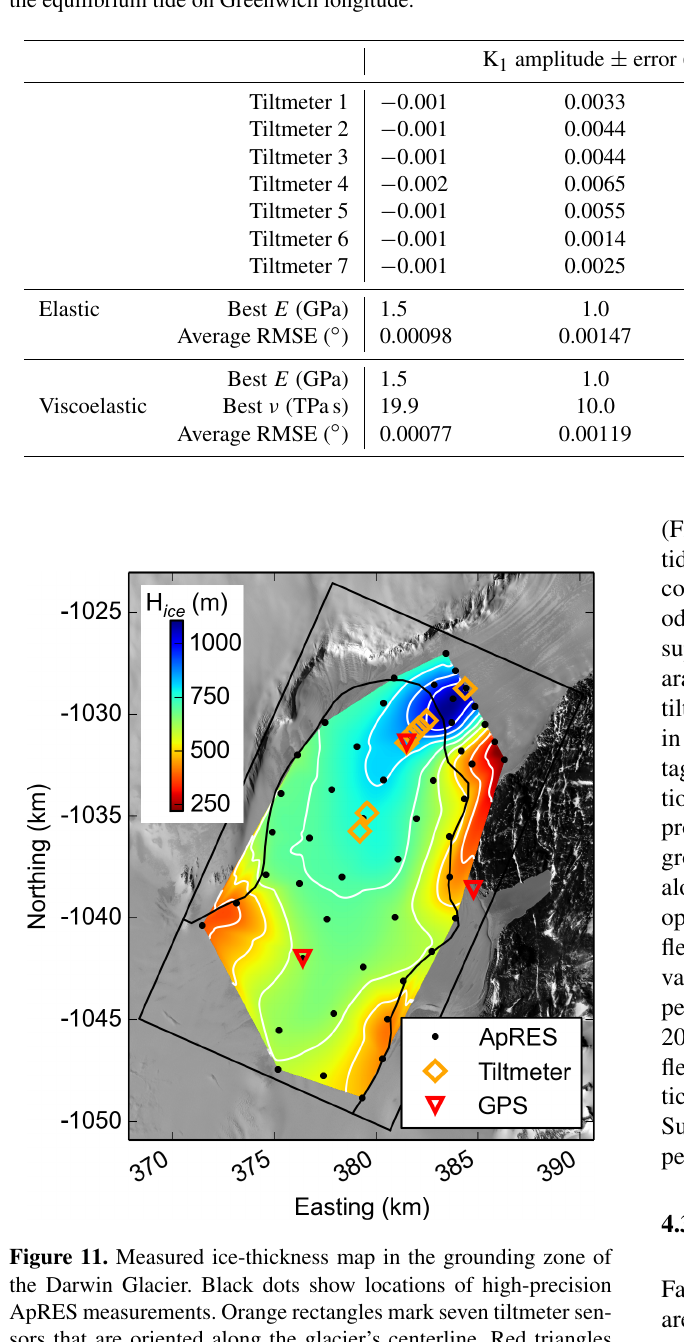
Table 3. Amplitude and phase of the K 1 tidal constituents from harmonic analysis of tiltmeter measurements and values of the rheological parameters to minimise the average RMSE. Amplitudes are given in degrees; phases are the phase lag of the K 1 constituent with respect to the equilibrium tide on Greenwich longitude.